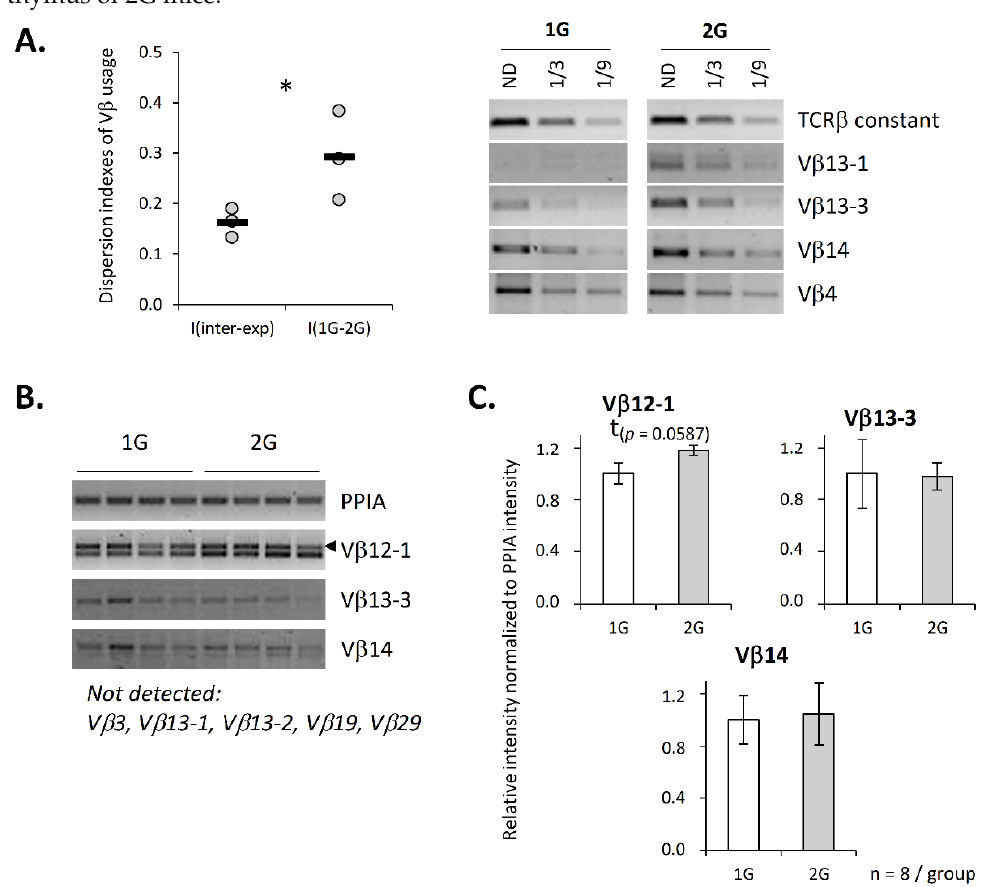
Figure 2. Hypergravity affects V β segments’ usage and germline transcripts. ( A ) V β segments’ expression was evaluated by semiquantitative PCR. Each experiment was performed using a pool of mRNA from 8 to 11 mice. The relative intensity for each of the 11 studied V β segments was normalized over TCR β constant region amplification. The right panel presents the V β segments’ amplification results from one representative experiment out of three. Then, dispersion indexes were calculated to evaluate variation between experiments (I(inter-exp), used as reference) and to evaluate variation between 1G and 2G conditions in each experiment (I(1G–2G)). The graphic (left panel) presents dispersion indexes calculated for each experiment (dot) and the mean of three independent experiments (black line). ND = not diluted. ( B , C ) Expression of V β germline transcripts evaluated by semiquantitative PCR. ( B ) Example of amplification observed for four mice in each group. ( C ) Histograms presenting the relative intensity of V β germline transcripts amplification normalized to PPIA intensity. A total of 8 V β germline transcripts were tested, and only four were detected under our conditions. Data are mean ± SEM of eight mice per group. Mann–Whitney tests were used to reveal statistically significant differences. * p < 0.05, t indicates a tendency.